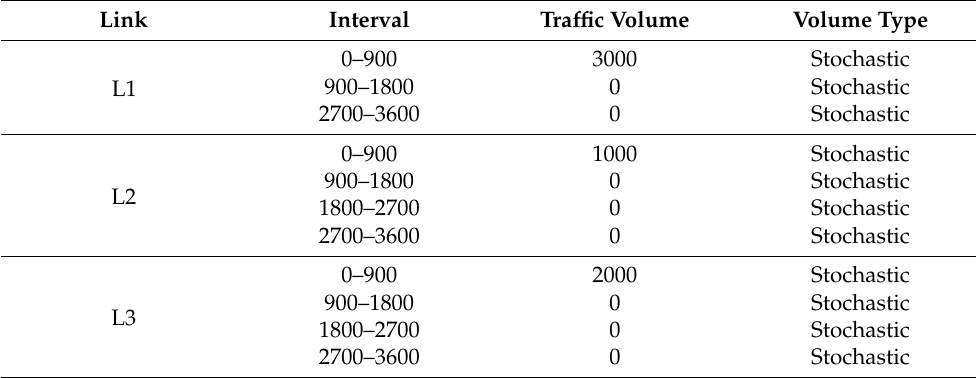
Table 1. Synthetic traffic demand assigned to links in the network. Link Interval Traffic Volume Volume